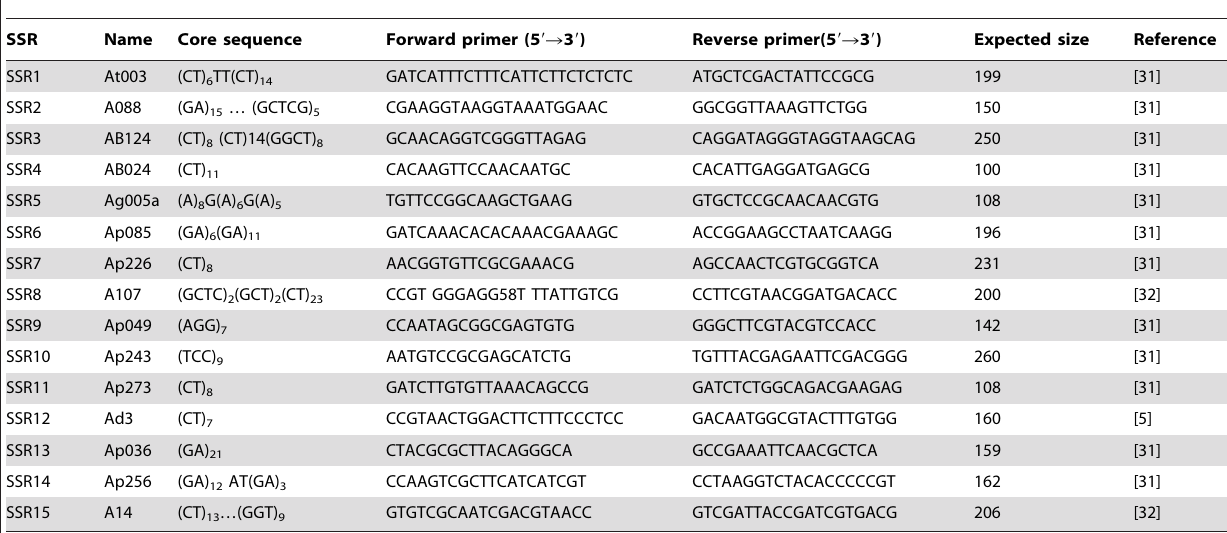
Table 1. Detailed information of microsatellite